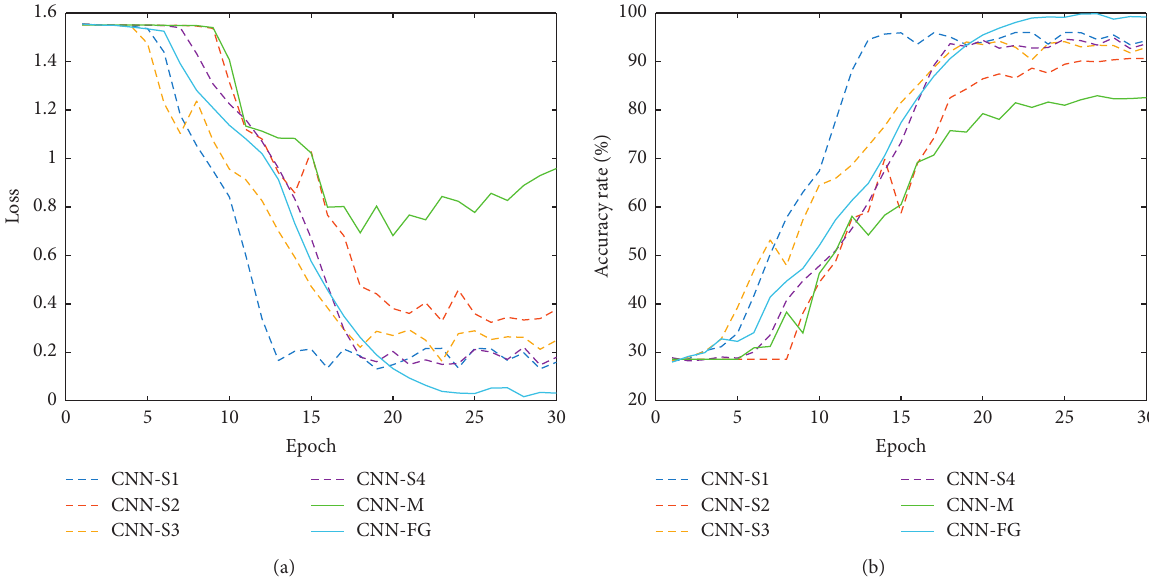
Figure 16: The comparison of traditional methods and fine-grained classification algorithm. (a)The comparison of test loss drop curves. (b) The comparison of faults diagnosis accuracies. Table 5: Comparison of fault diagnosis accuracies between traditional CNN models and fine-grained CNN model. Working